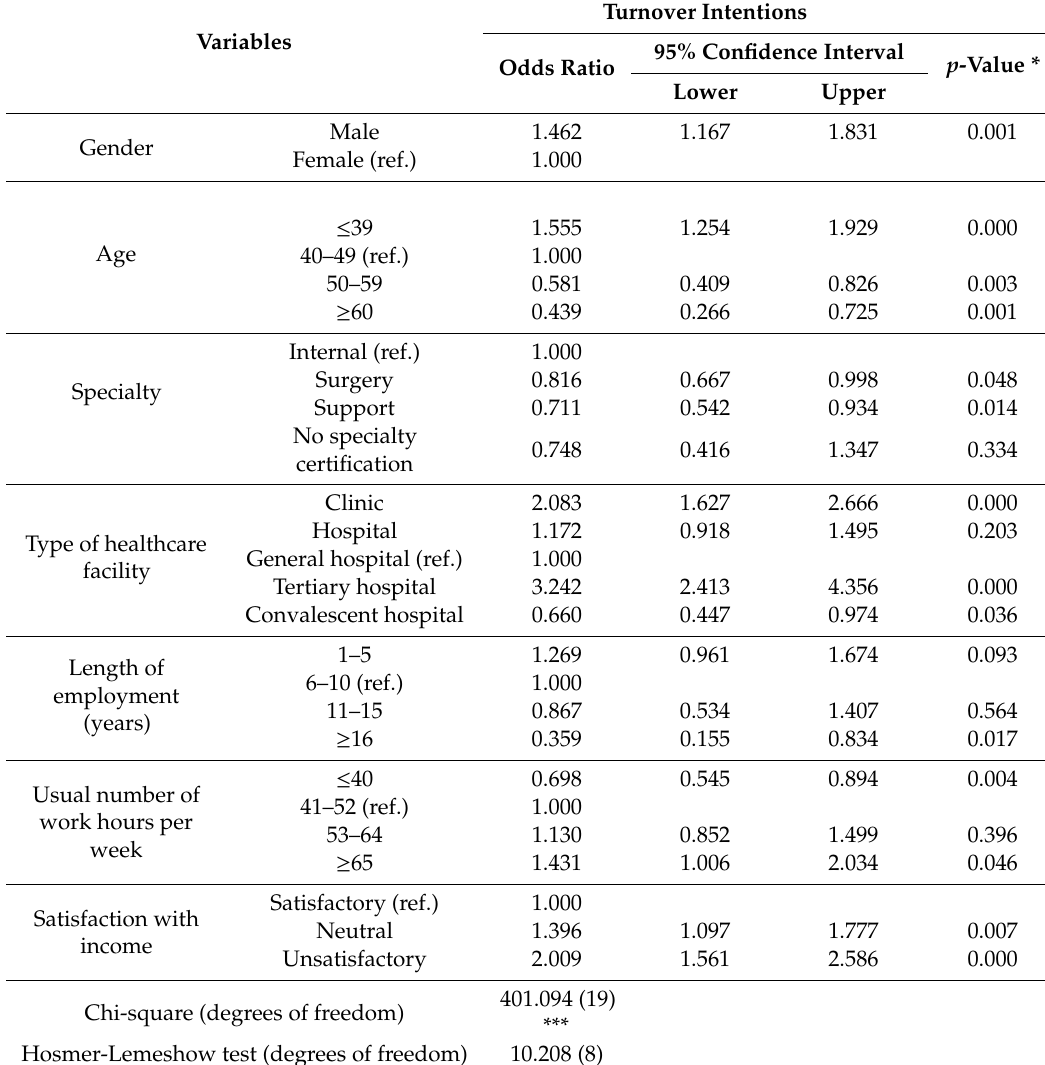
Table 2. Relationships of demographic characteristics and work-related variables to turnover intentions; odds ratios and confidence intervals ( n =